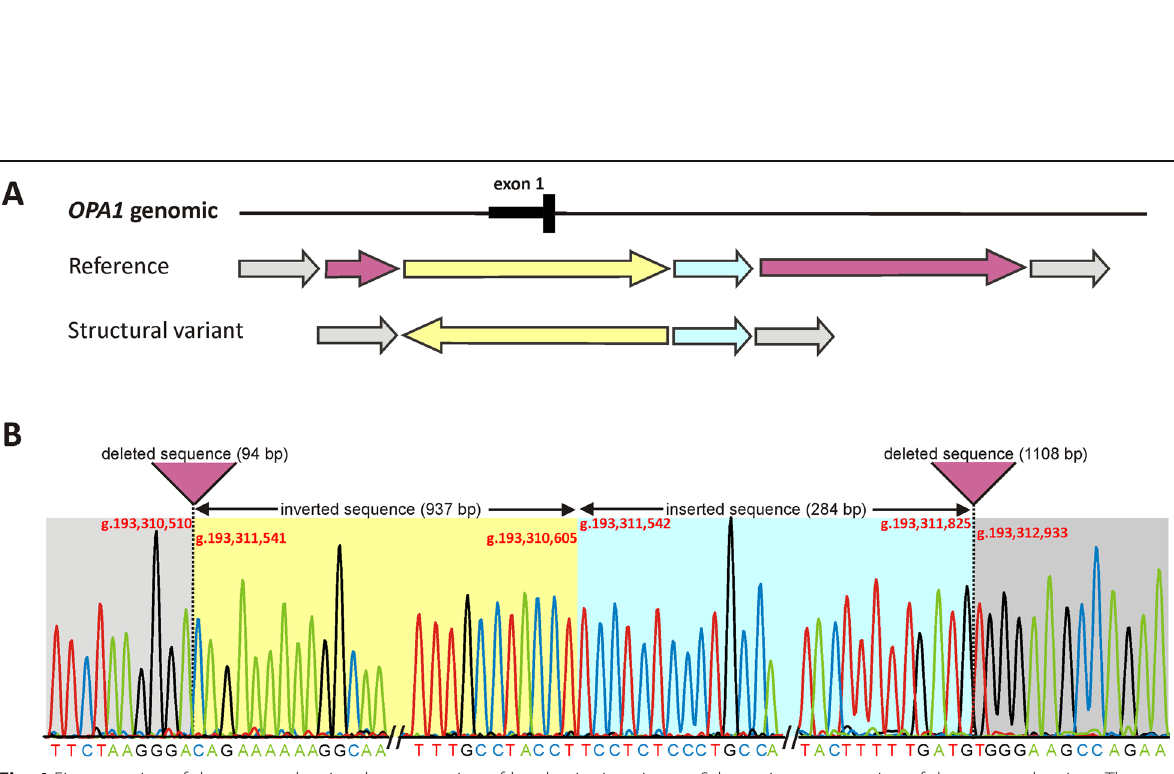
Fig. 4 Fine mapping of the structural variant by sequencing of breakpoint junctions. a Schematic representation of the structural variant. The color of the arrows indicates normal sequence (grey), inverted sequence (yellow), inserted sequence (blue) and deleted sequence (pink). b Sanger sequencing of breakpoint amplicons. The vertical dashed lines highlight the 5´ and 3 ′ breakpoints. The background colors of the electropherogram correspond to the scheme shown in (A). The deleted sequences are indicated by pink triangles. Note that the inserted sequence is actually “ leftover original sequence ” between the deletion and inversion